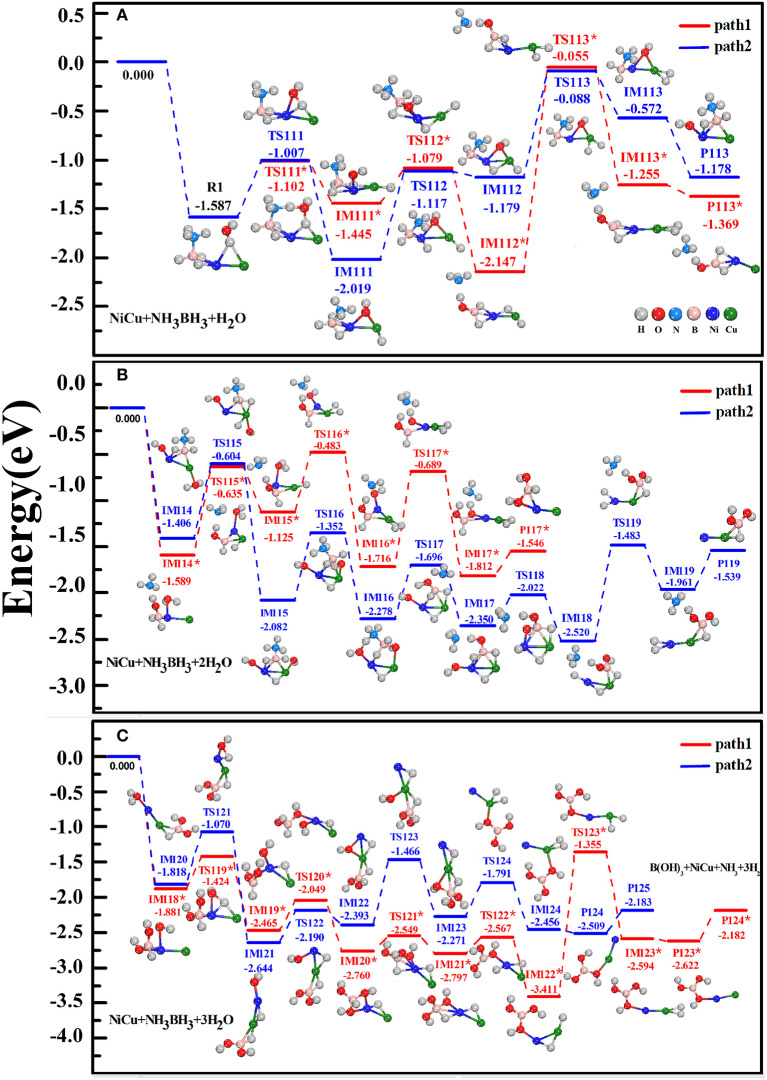
Schematic energy profiles of hydrogen production from the catalytic hydrolysis of AB in the presence of NiCu dimer. The stepwise attacks involving three H2O molecules, named as H2Ost, H2Ond, H2Ord, are sequentially considered in (A–C). The reactant, transition state, intermediate state, and product are denoted by R1, TS, IM, P, respectively.